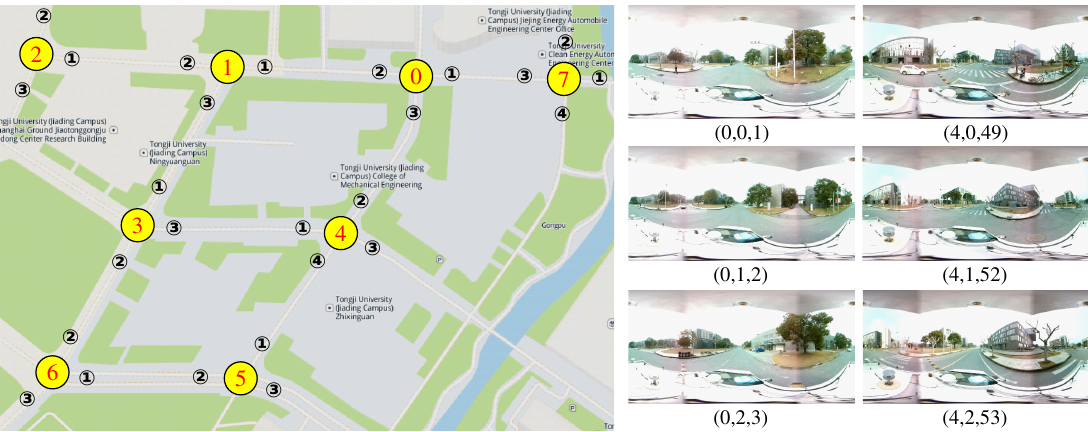
Figure 7. Selected campus intersections and labeled examples. We label intersection IDs according to the driving route and the global IDs in designed order (e.g., clockwise). Each image is labeled with a tuple of (intersection ID, attribute ID, global